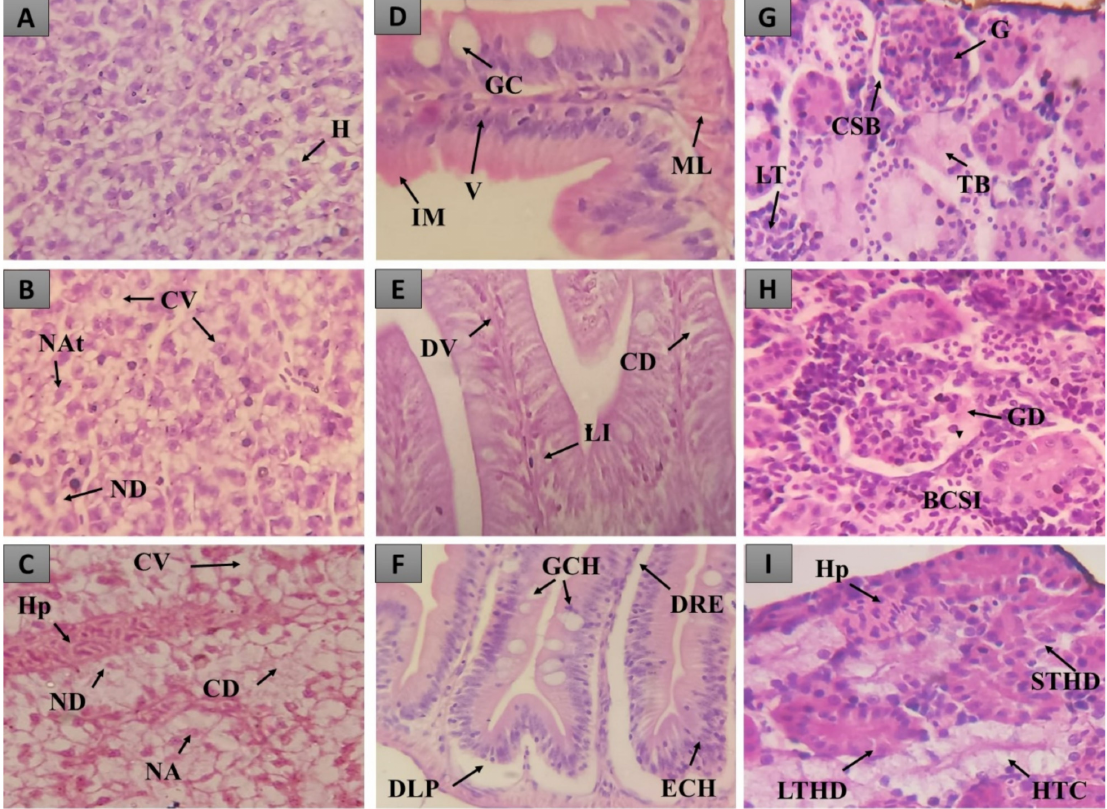
Figure 9. Histopathological changes observed in the liver, intestine and kidneys of adult ze- brafish in the evaluation of the effects of control (saline solution and DMSO, p.o.) and HELTr (100–200–500 mg/kg, p.o.) groups. In ( A – C ), liver tissue with normal hepatocytes (H), cytoplasmic vacuolization (CV), nuclear atypia (NAt), nuclear degeneration (ND), cellular degeneration (CD), nuclear atrophy (NA) and hyperemia (Hp) are observed. In ( D – F ), the intestinal tissue is distin- guished by normal goblet cells (GC), villi (V), intestinal mucosa (MI), muscular layer (ML), dilatation of vessels present in the villi (VD), leukocyte infiltration (LI), goblet cell hyperplasia (GCH), epithelial cell hypertrophy (ECH), displacement of lamina propria (DLP) and detachment of the epithelial lining (DRE). In ( G – I ), renal tissue with normal tubules (Tb), glomerulus (G), Bowman’s capsule space (BSC), lymphoid tissue (LT), glomerular degeneration (GD), increase in Bowman’s capsule space area (ISBR), hyperemia (Hp), mild (MTHD) and severe (STHD) tubular hyaline